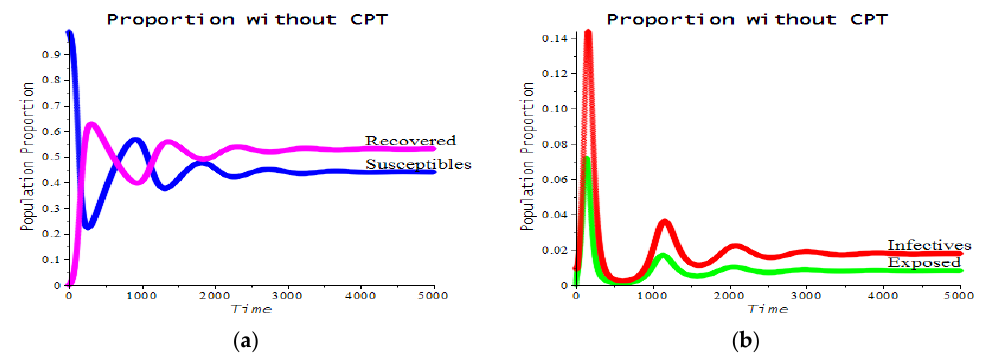
Figure 2. A graph of the SEIR model without CPT showing the susceptible and recovered classes ( a ) and the exposed and infective classes ( b ). The SEIR parameters were μ = 1/75, β = 0.95, δ = 0.90, and α = 0.40, with initial values of S 0 = 0.99, E 0 = 0, I 0 = 0.01, and R 0 = 0. The resulting equilibrium was approximately S = 44%, E = 1%, I = 2%, and R = 53% with the basic reproduction number R 0 = 2.265.